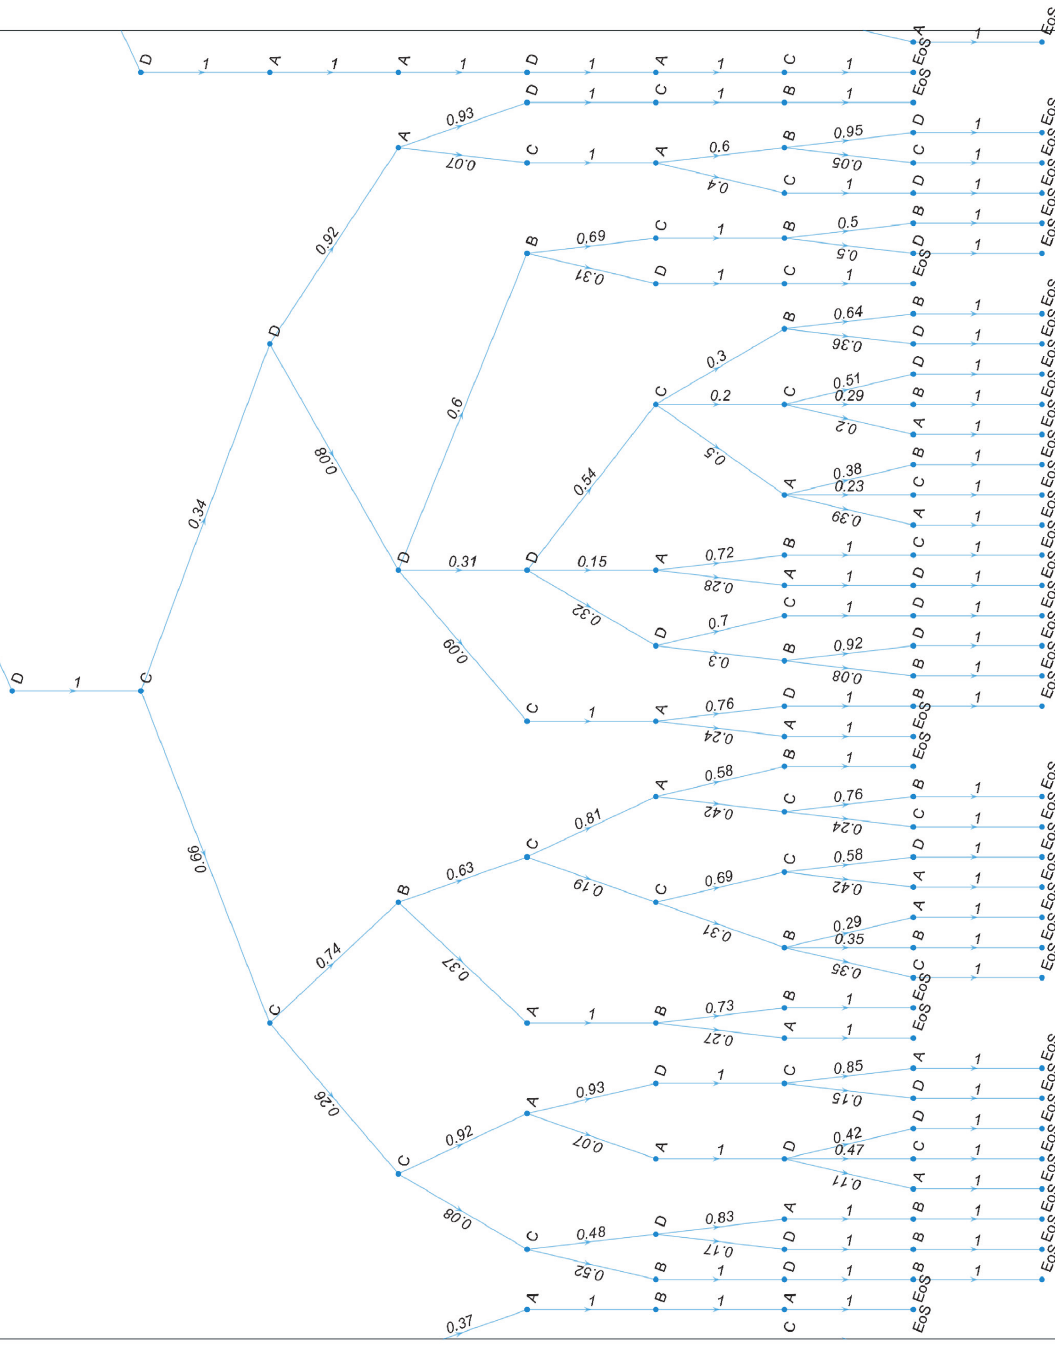
Figure 12: The state transition probabilities of the full tree-based system, assuming [A D] event